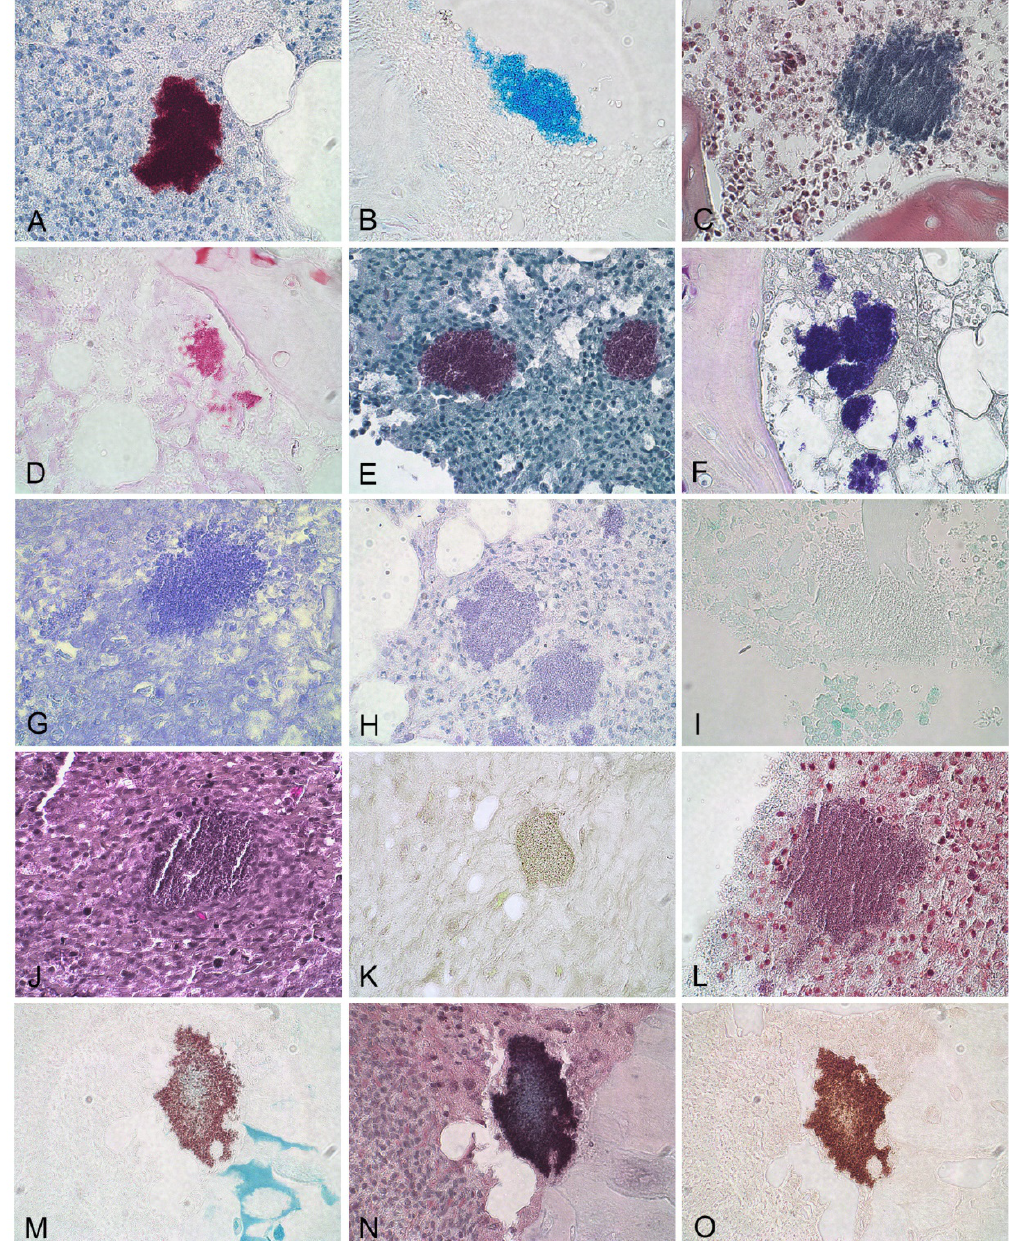
Figure 3. Immunohistochemical (A), histochemical (B-L) and combined histochemical/immunohistochemical (M-O) stains applied to porcine S. aureus infected bone tissue. A: S. aureus immunohistochemistry, B: Alcian blue pH3, C: Luna, D: Methyl green-pyronin, E: Safranin O, F: Gram, G: Crystal Violet, H: Oil red, I: Feulgen, J: Verhoeff, K: Alzian Red, L: Masson trichome, M: Alcian blue pH 3 + S. aureus immunohistochemistry, N: Luna + S. aureus immunohistochemistry, O: Methyl green-pyronin + S. aureus immunohistochemistry. All pictures are at 60x